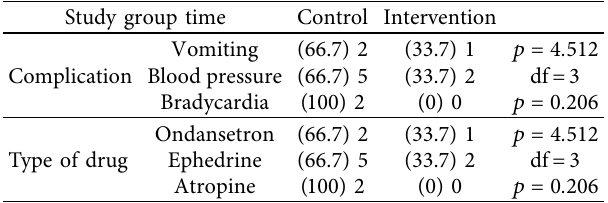
Table 2: Comparison of side efects and prescription